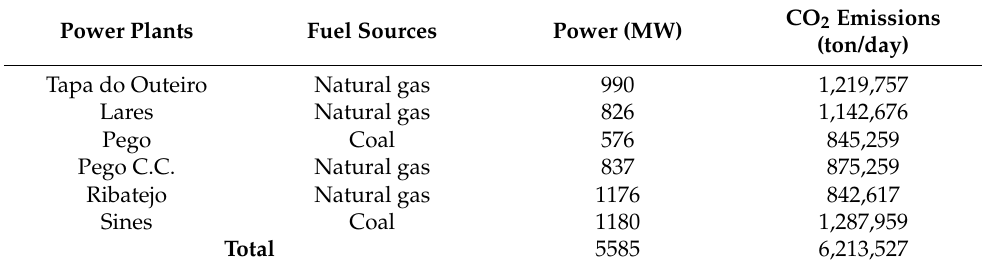
Table 10. Thermoelectric power plants [62].